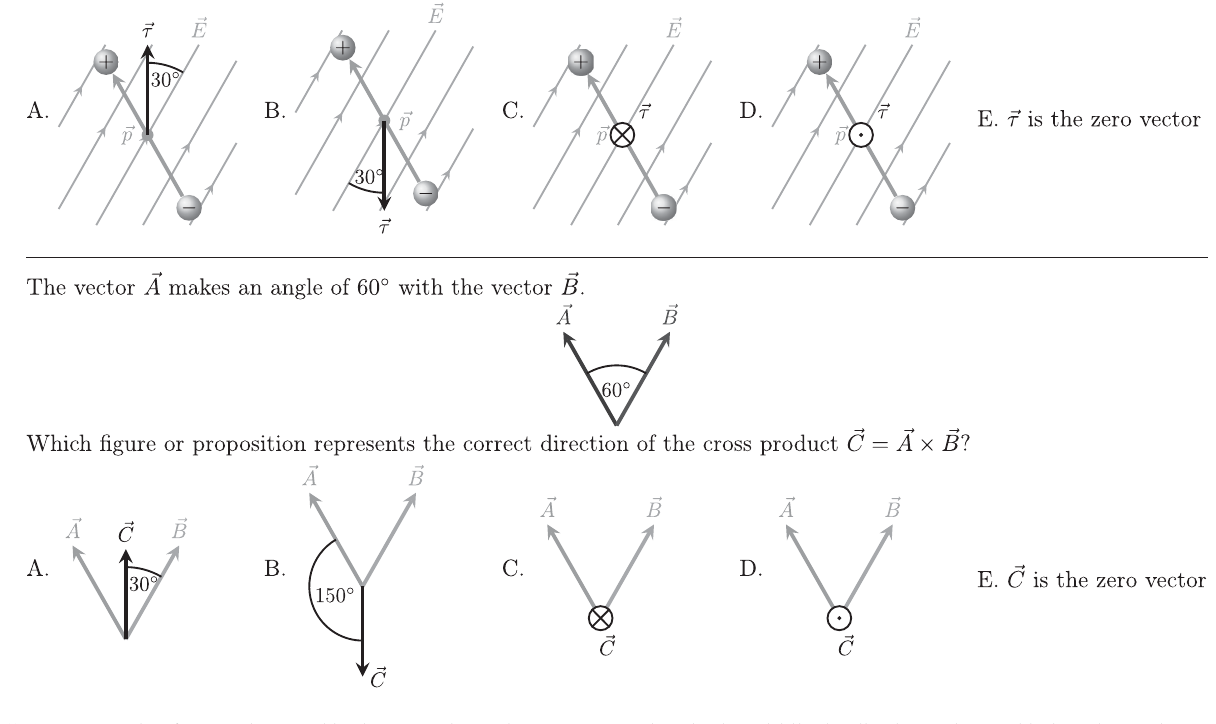
FIG. 1. Example of a question used in the test. Above the Lorentz version, in the middle the dipole version and below the math version. On the test, the five answer alternatives were ordered randomly for each